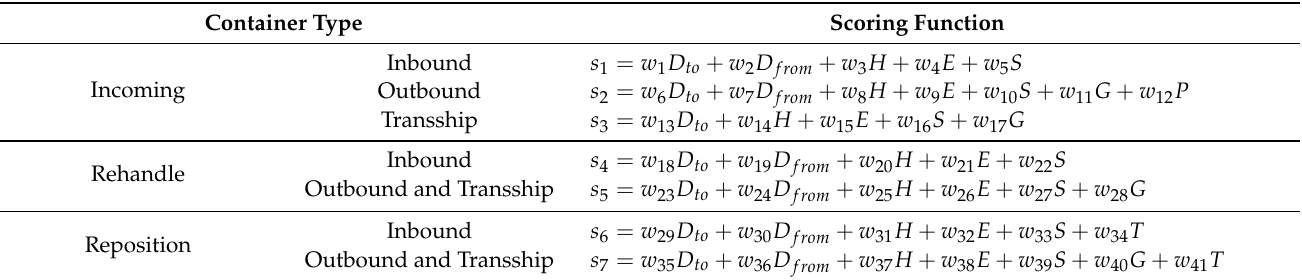
Table 2. Scoring function for each of the seven container